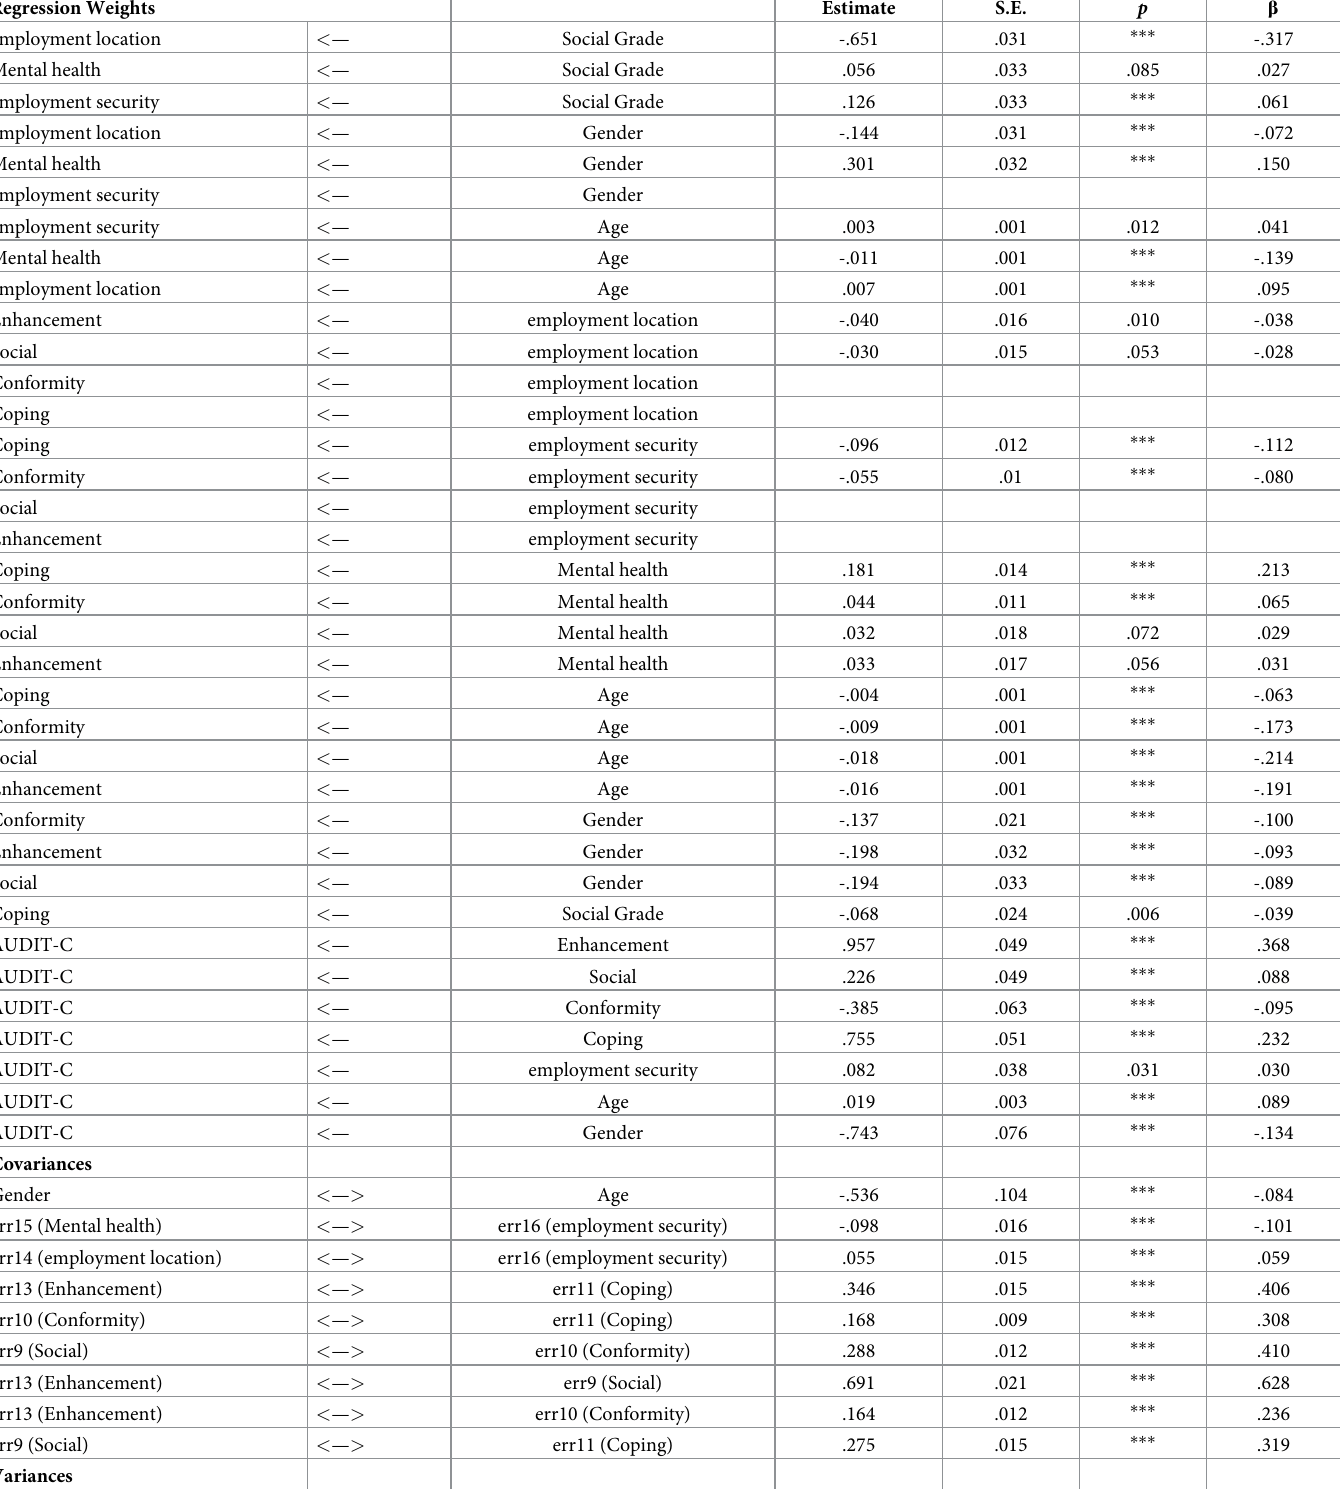
Table 3. Final model